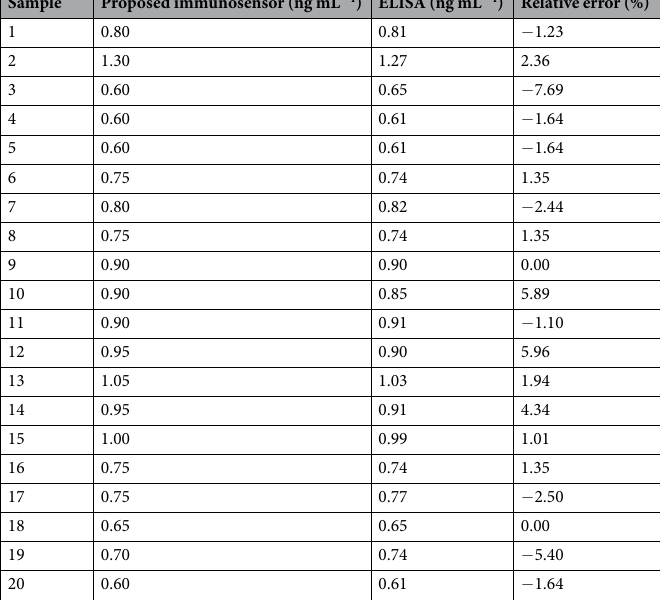
Table 1. Assay results of clinical serum samples using the proposed method and ELISA.